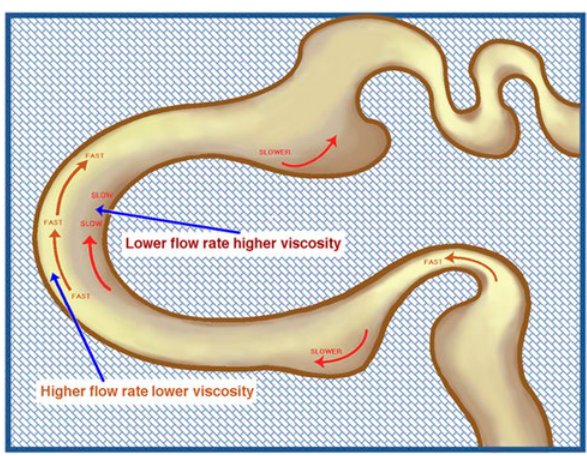
Figure 74. Diagram of an intrusive ptygmatic vein comprising a pasty mixture of particulate sediment components like clay, poly- meric silica, chlorite, etc. More hydrous and lower viscosity compo- nents tend to separate from the mixtures when they are mobilised. At higher rates of flow these more fluid materials are even less vis- cous. This causes their intruding veins to bend tortuously as they flow along pressure gradients, "jet" through thin connecting necks, well into bulbous forms, or diffuse in cloud-like masses into the plastic host rocks. The viscosity is dependent on the rate of